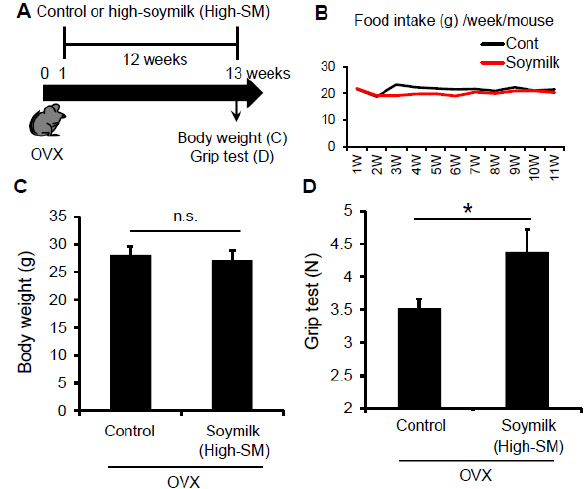
Figure 3. Effect of High ‐ SM intake on grip strength in OVX mice. ( A ) OVX mice were fed with high soymilk (High ‐ SM) for 12 weeks. Muscle strength was measured by a grip strength meter at 12 weeks followed by the start of soymilk intake. Food intake ( B ), body weight ( C ), muscle strength ( D ) were shown (control, n = 7; soymilk, n = 8 mice). Data represent the mean ± SEM. n.s., not significant. An asterisk denotes a significant difference from control ( * p < 0.05).